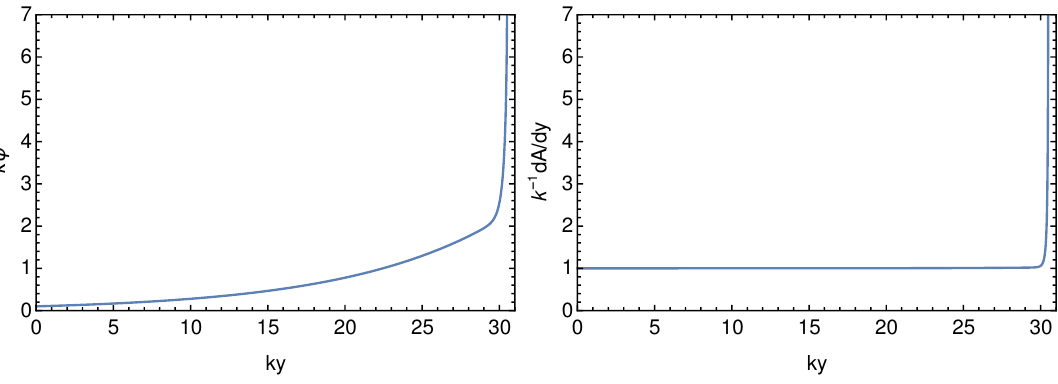
Figure 1 . Typical background solution to the bulk equations (2.5){(2.7). For this case, we have taken the quadratic potential with (cid:20) = 0 : 5 k (cid:0) 3 = 2 and (cid:15) = 0 :